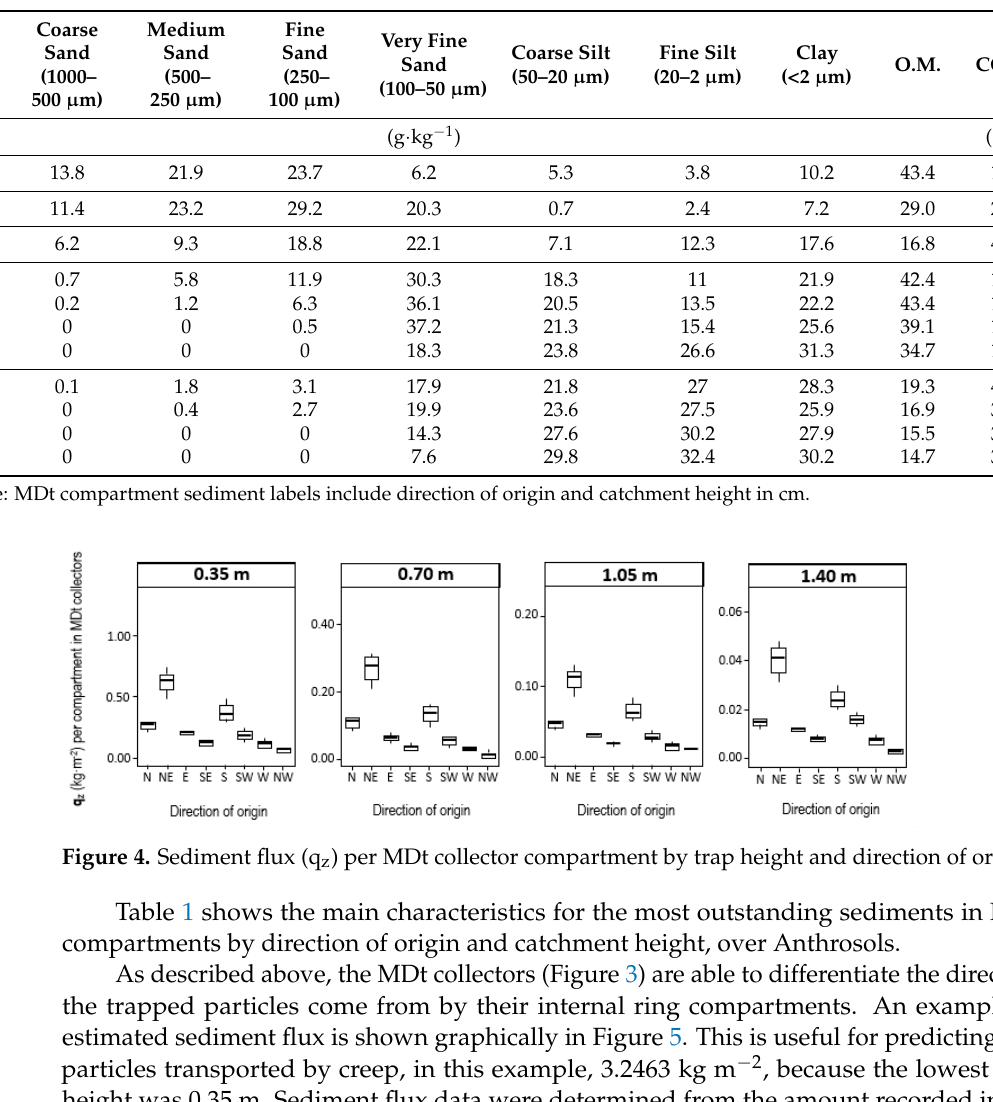
Table 1. Characteristics of soils and sediments in MDt compartments.